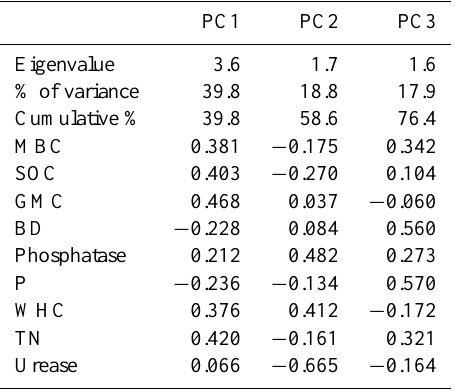
Table 2. Principle component analysis (PCA) of soil quality indica- tors of soil samples with different years of extraction of